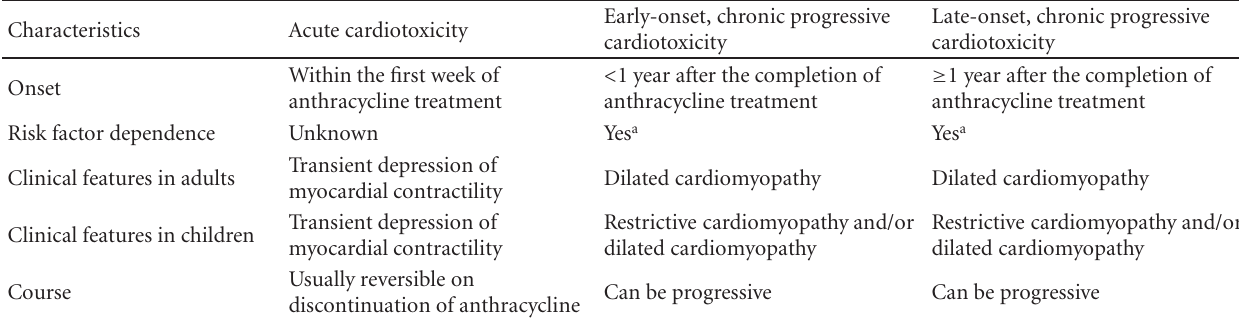
Table 1: Characteristics and course of anthracycline-induced cardiotoxicity